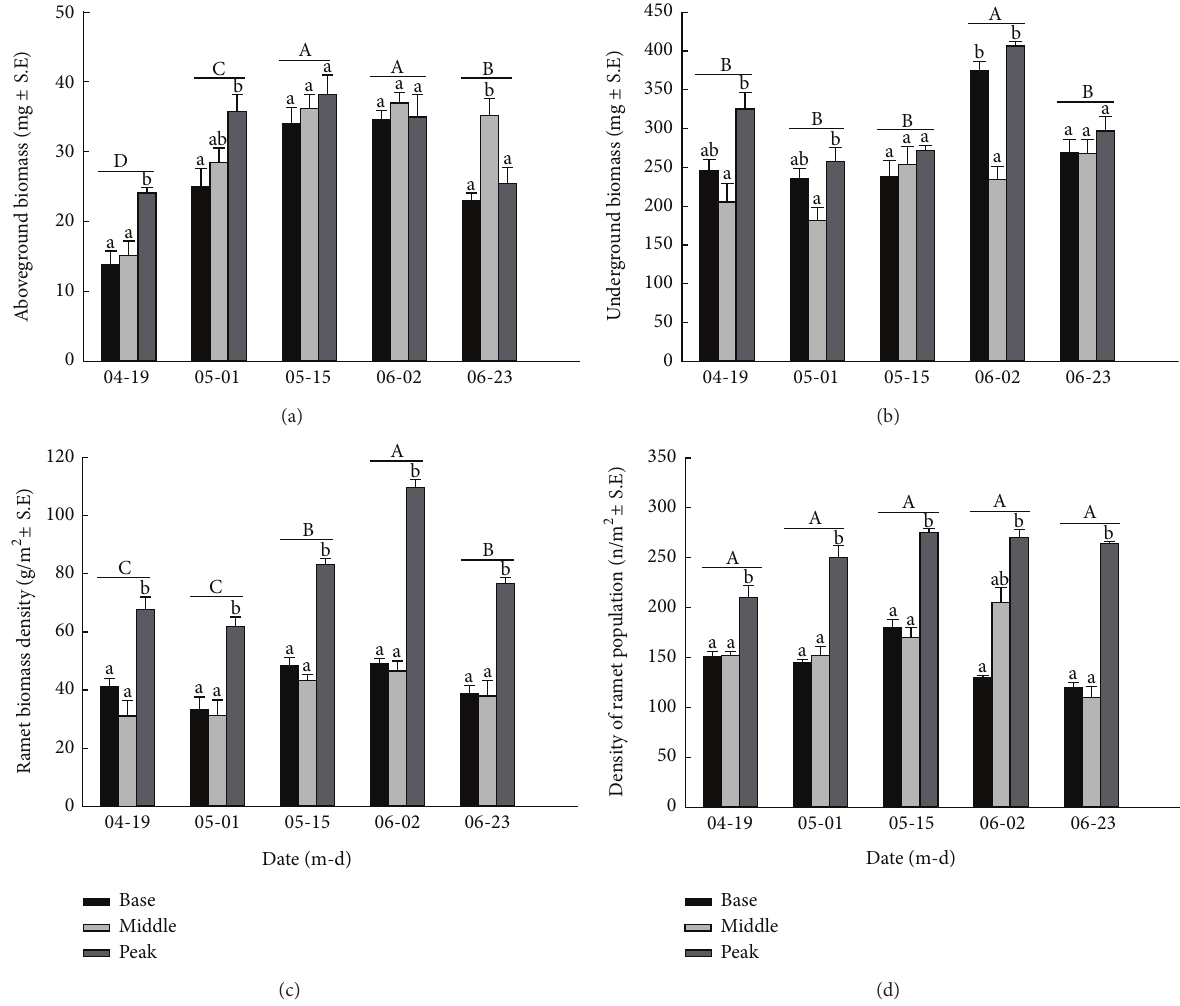
Figure 4: Dynamic curves of aboveground biomass (a), underground biomass (b), ramet biomass density (c), and ramet population density (d) of Carex physodes at different locations on different sampling dates. Different lowercase letters indicate a significant difference of ramet heightamongthreelocationsatthesamesamplingdate( 𝑃 < 0.05 ).Differentuppercaselettersindicateasignificantdifferenceamongsampling dates at the three locations ( 𝑃 < 0.05